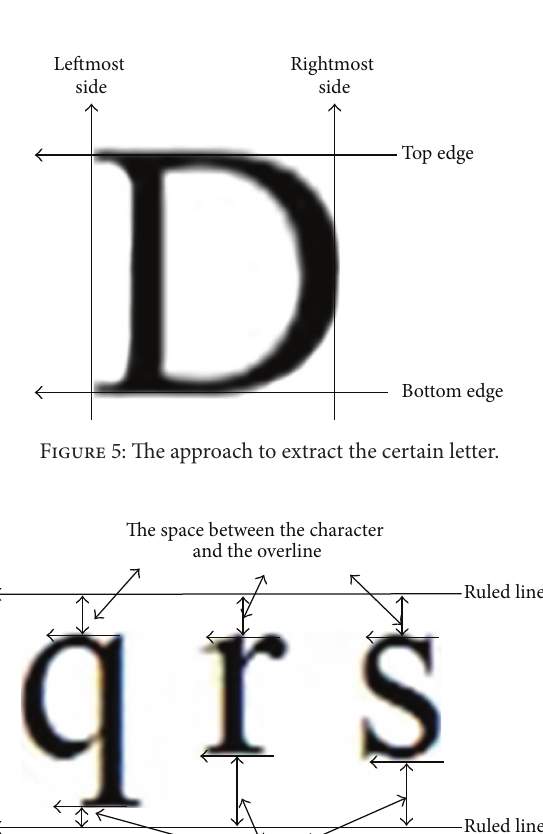
Figure 4: The flowchart of our methodology.